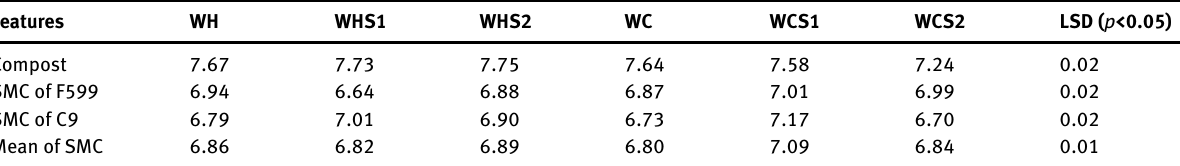
Table 7: The pH of